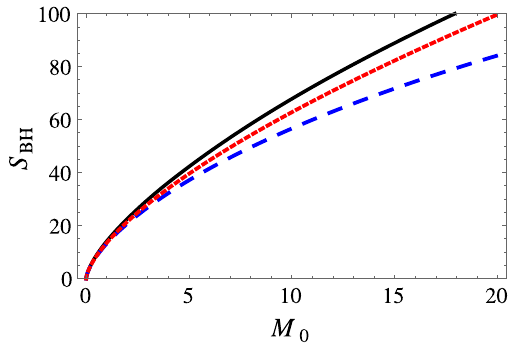
Fig. 4 Horizon radius as a function of M 0 for (cid:13) = 0 . 05, L = 2 and G 0 = 0 . 8.Theplotsforthenumericalsolution,theexpansionfor (cid:13) (cid:12) 1 and the classical case correspond to the black solid line, dashed blue line and short dashed red line, respectively